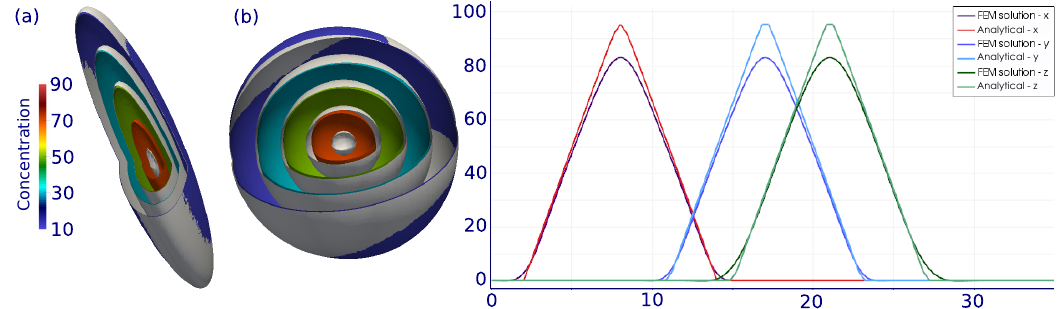
Figure 8. Results of 3-D rotation test. Isosurfaces of concentration 10, 30, 50, 70 and 90 for the FEM solution (in colour) and the analytical solution (in solid grey) at (a) t total / 2 and at (b) t total . Note that for the FEM solution the isosurface 90 is missing as the maximum values of concentration decreased to 87 . 5 (at t total / 2) and 83 (at t total ). (c) Cross profiles parallel to the x , y and z axis for the analytical and the FEM solution at t total